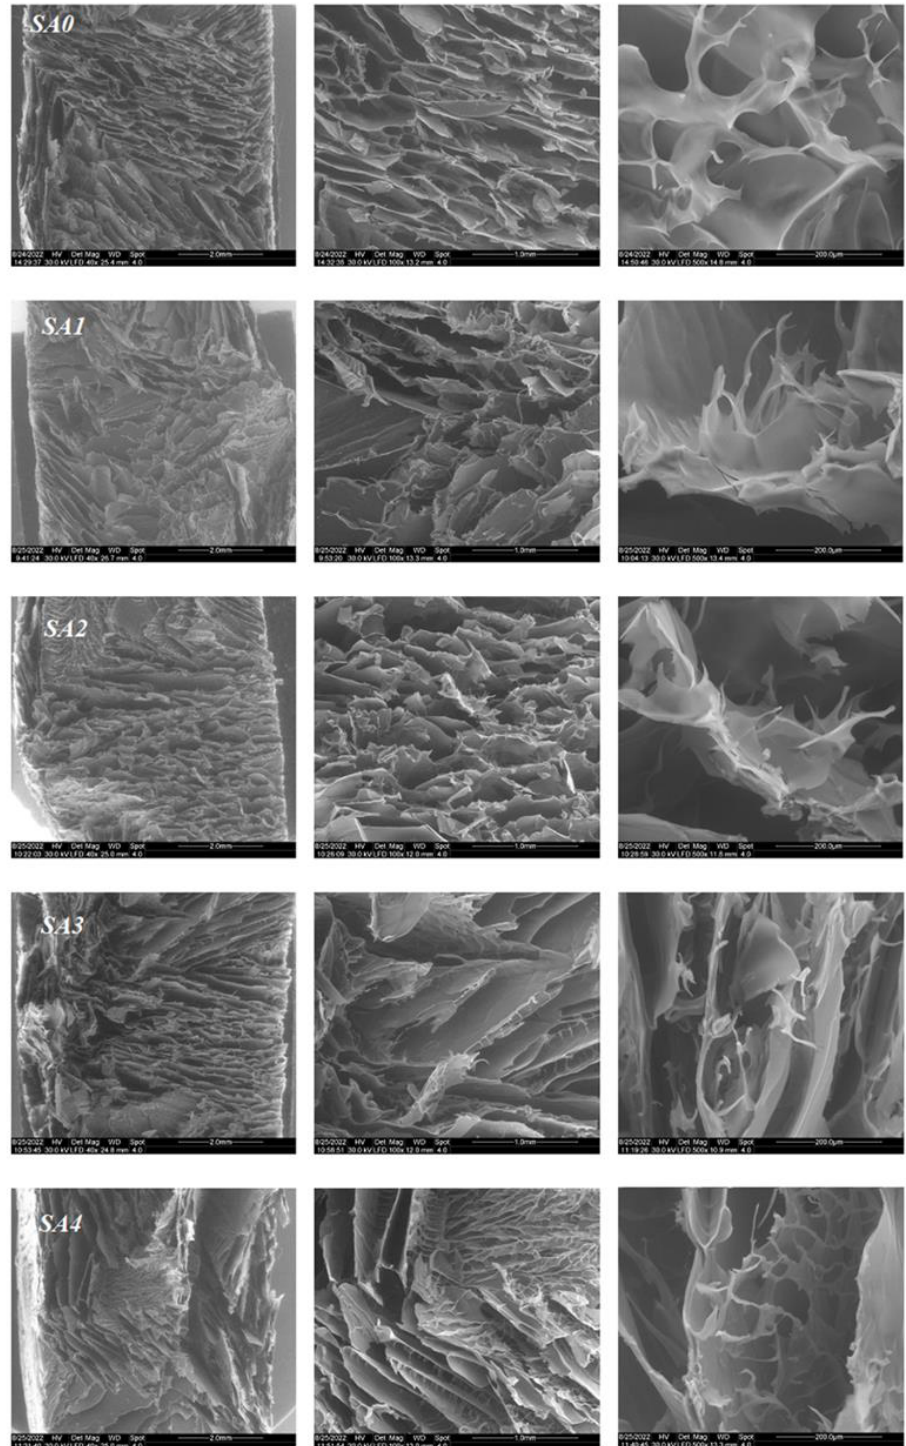
Figure 4. SEM images of the obtained lyophilized samples (×40, ×100, ×1500 magnitude).